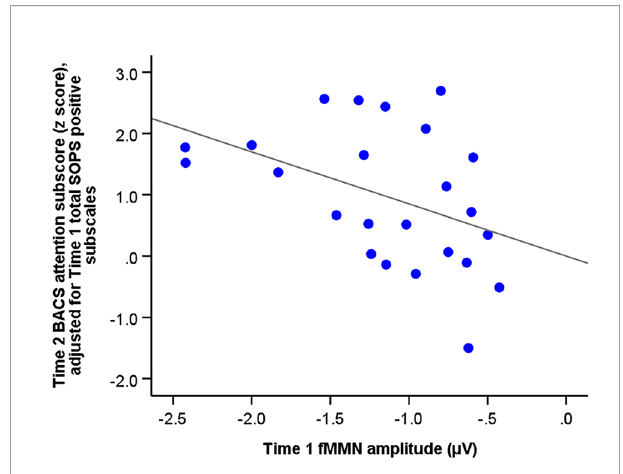
FIGURE 3 | The correlation between the amplitude of frequency mismatch negativity (fMMN) of individuals at ultra-high risk for psychosis at baseline (Time 1) and the Brief Assessment of Cognition (BACS) attention subscore (z score) at Time 2 adjusted for total SOPS positive subscales at baseline (Time 1).